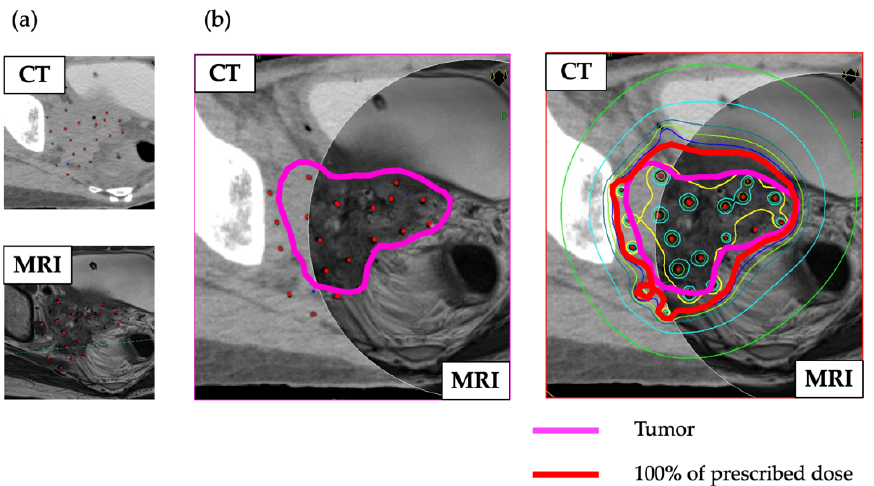
Figure 4. ( a ) CT and MRI of a patient evaluated after implantation. ( b ) Combined CT and MRI of the same patient enabled clear visualization of the tumor contours (pink line). The HR-CTV was mostly covered by the 100% prescribed dose (red line).